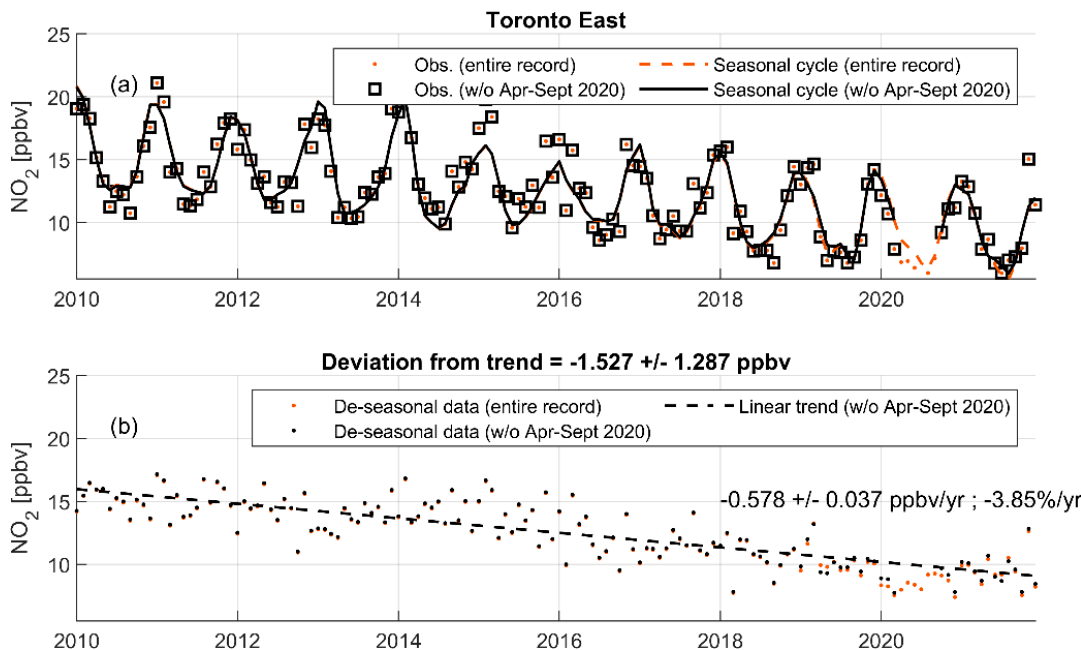
Figure 8. Surface NO 2 trend fitting results from the statistical model at the Toronto East site. Red symbols represent data and fittings for the entire observation record. Black symbols represent data and fittings for the records without data from April to September 2020. Panel ( a ) shows the observations and fitted seasonal cycles; panel ( b ) shows the de-seasonal data and fitted linear trend.